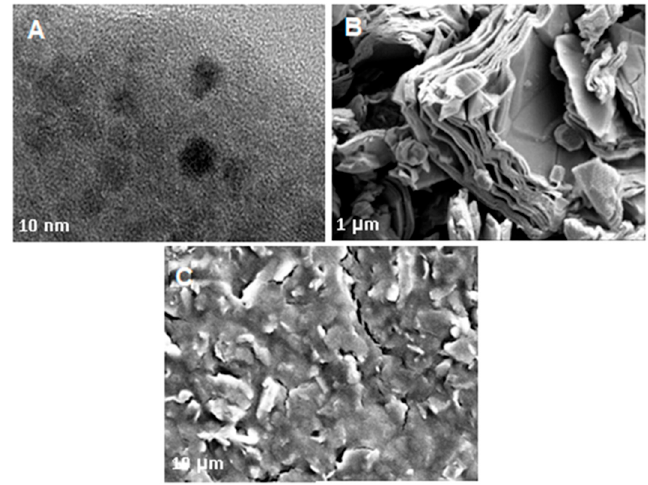
Figure 3. SEM image of ( A ) HRTEM image of GQD. Scale bar corresponds to 20 nm; ( B ) mXene, Ti 3 C 2 , and ( C ) PEDOT:PSS/Ti 3 C 2 .